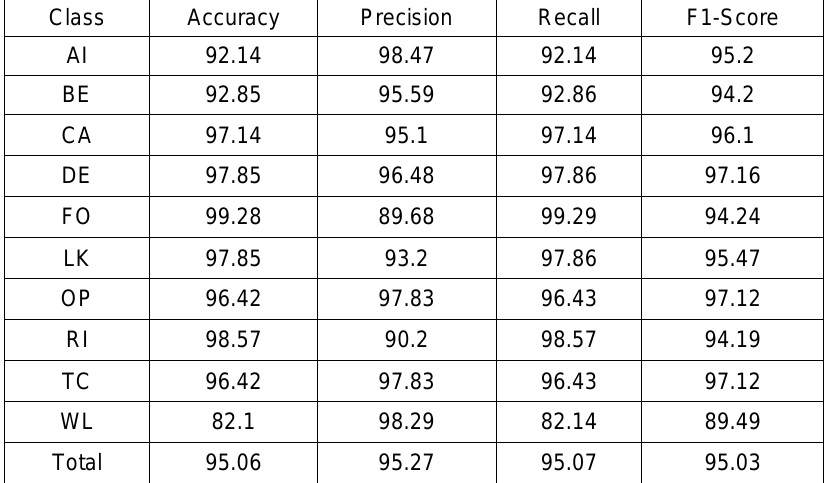
Table 7. Performance Metrics of Optimized RSISC-16 Net